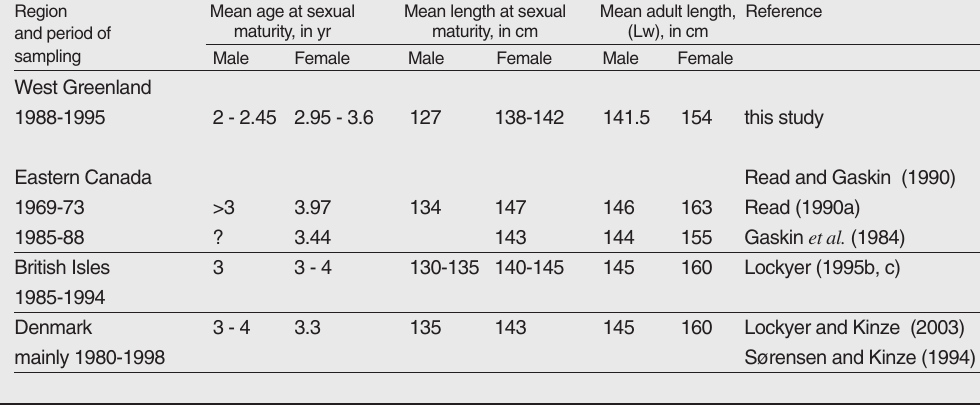
Table 2. Comparison of age- and size-related biological parameters in different populations of harbour porpoises, modified after Lockyer et al. (2001).